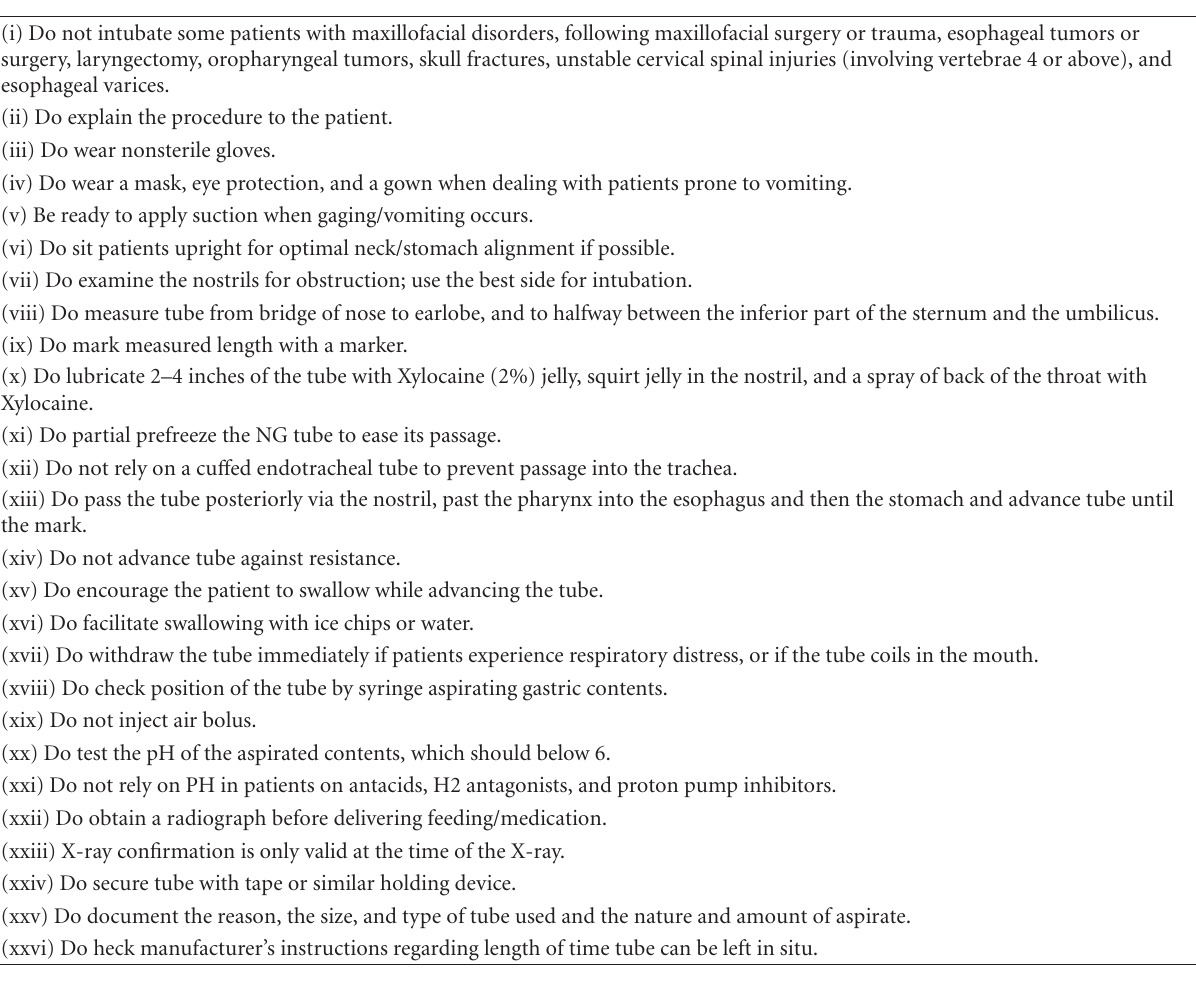
Table 3: Dos and Don’ts of NG Tube Placements [63].